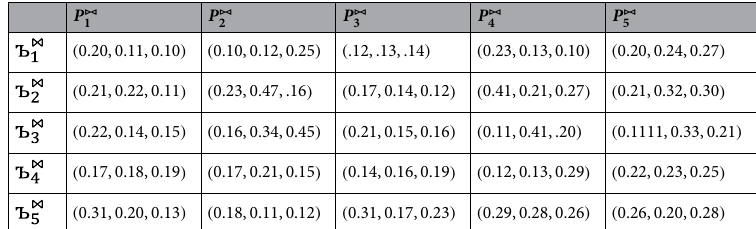
Table 4. Picture fuzzy soft data for F